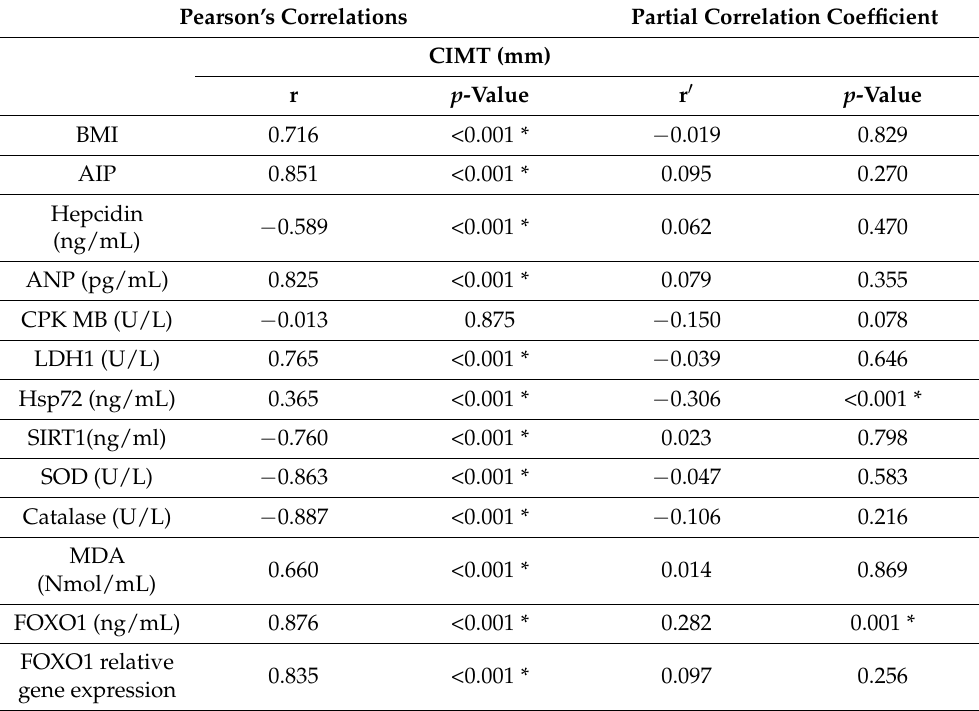
Table 2 shows correlation analysis between mean CIMT and β stiffness and atheroscle- rotic risk factors in β -TM patients. It shows a significant positive correlation between CIMT with MDA, HSP72, ANP, LDH, FOXO1, and FOXO1 gene expression but a significant negative correlation with hepcidin, SOD, catalase, and SIRT1. Partial correlation shows a significant correlation between FOXO1 and HSP 72 with CIMT. Table 2. Pearson’s and partial correlations between CIMT and among all studied groups as regards all the studied parameters.